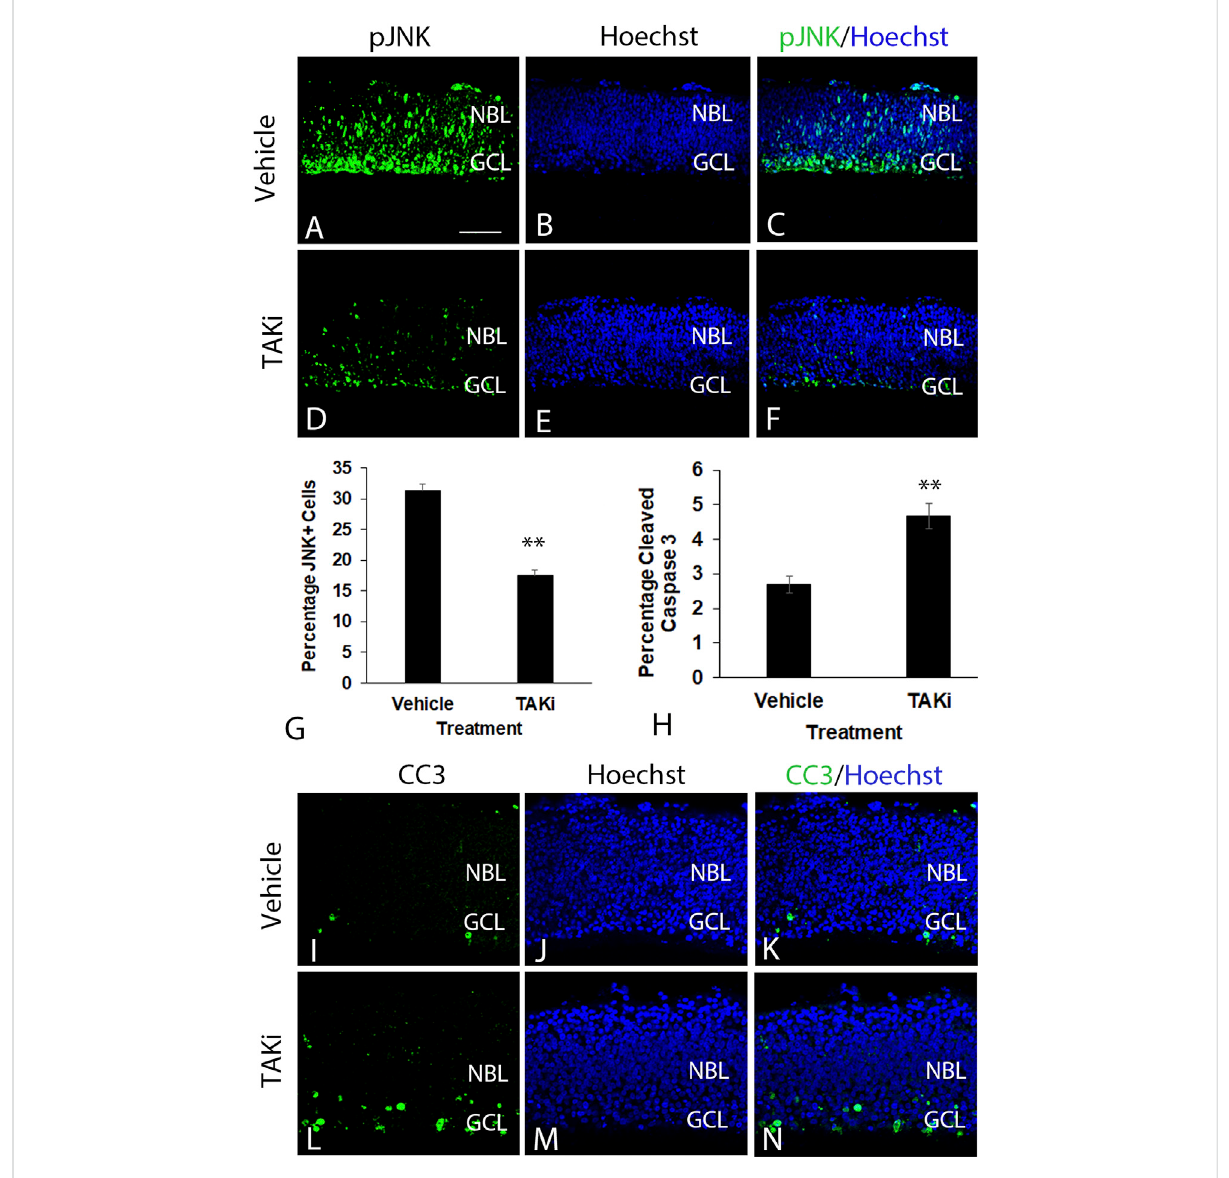
Incomparisontovehicle-treated retinas,TAKi-treatedretinashaveadecreaseinJNKlabelingandanincreaseincleaved-caspase 3labeling.E6 chick retinal cultures were treated with vehicle or 2 μ m TAK1 inhibitor (Sanjo et al., 2019) for 24 h and sections through retinas were co-labeled for downstream kinase phospho- c-jun N-terminal kinase [pJNK; (A,C,D,F) ] or apoptosis marker cleaved caspase 3 [CC3; (I,K,L,N) ] and Hoechst dye for DNA [blue; (B,C,E,F,J,K,M,N) ]. Percentages of labeled cells were quanti fi ed in 3 separate retinas for pJNK+ cells (G) or cleaved caspase 3 (H) . Standard deviation isshown in (G,H) . A =50 μ m for images ( A – F and I – N ).Abbreviations:NBL, neuroblast layer; GCL,ganglion cell layer. Scale barin A = 50 μ m for images ( A – F and I – N